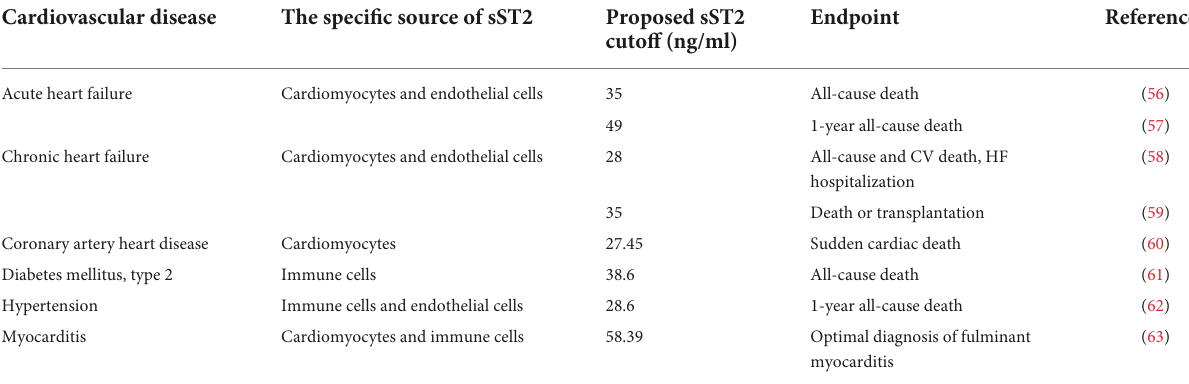
TABLE 3 Studies evaluating the association of soluble growth stimulation expressed gene 2 (sST2) in various cardiovascular diseases. Cardiovascular